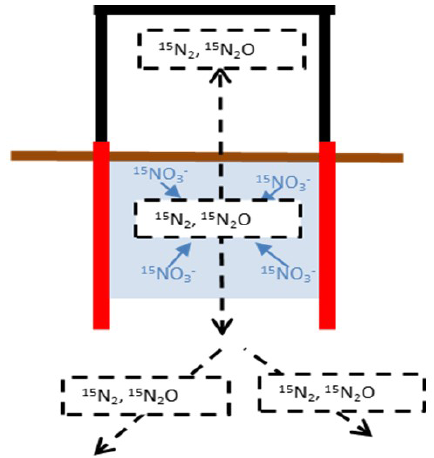
Figure 1. Conceptual model describing the dynamics of diffusive fluxes (black dotted arrows) of 15 N-labelled gaseous denitrification products evolved in a 15 N-labelled soil volume (shaded area) that is confined by a cylinder with open bottom to the subsoil but tem- porarily closed from above with a flux chamber to collect emitted